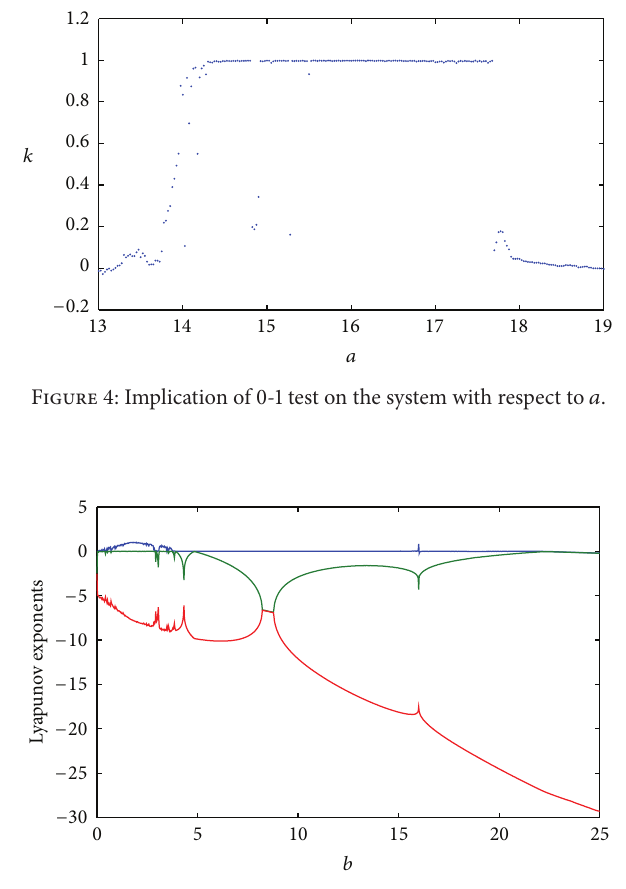
Figure 5: Lyapunov exponents spectrum of the system with respect to 𝑏 .